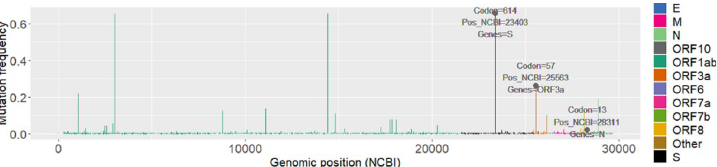
Fig 1. Global genomic frequency plot. Mutations of interest, P13L and Q57H, are labelled in the plot together with the D614G mutation for comparison.